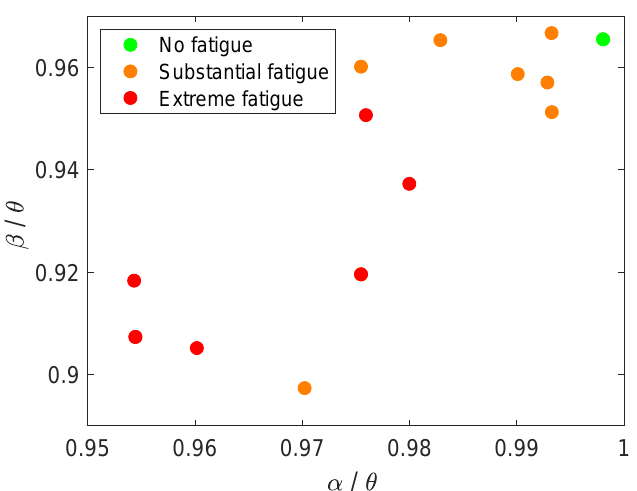
Figure 5. Two-dimensional representation of the most significantly correlated feature to FAS score: β / θ (C3), and α / θ (O2) in relation to their fatigue